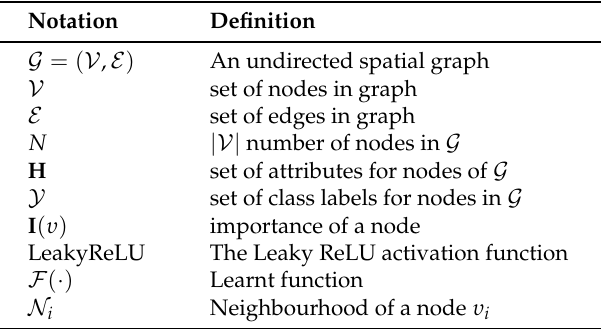
Table 1. Table of notations used and their